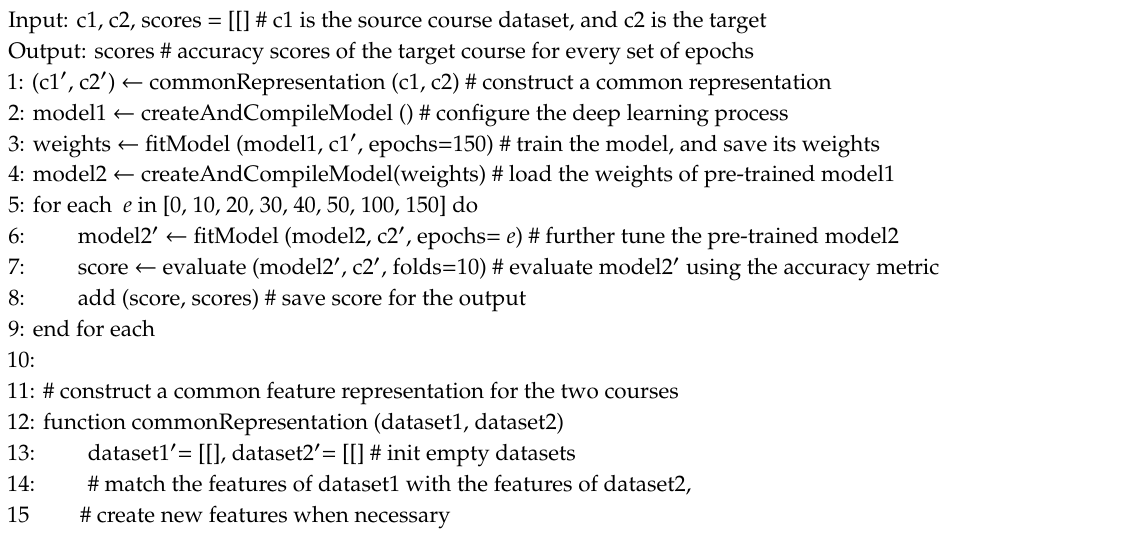
Algorithm 1 : Transfer learning through paired course using deep neural